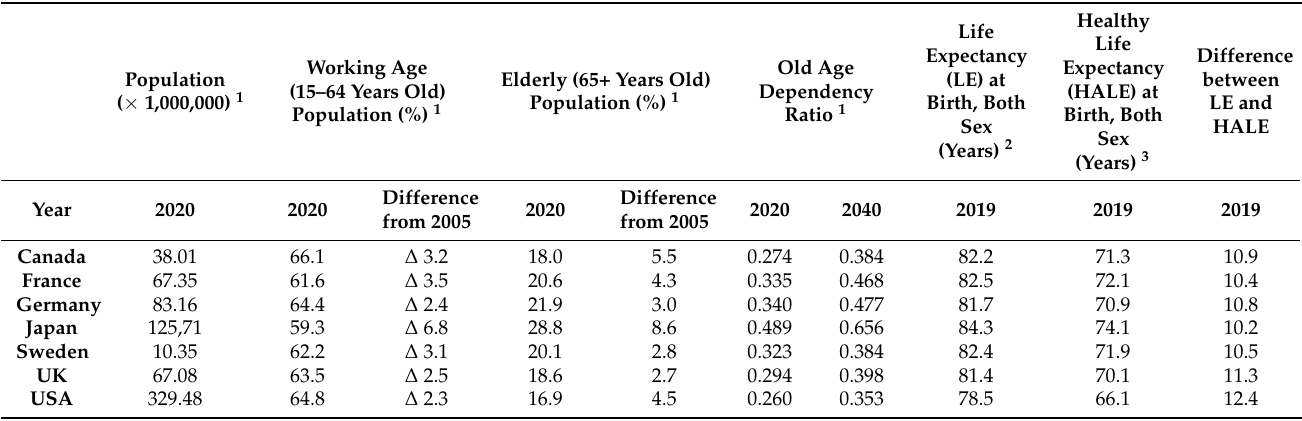
Table 1. Socio-demographic indicators among seven